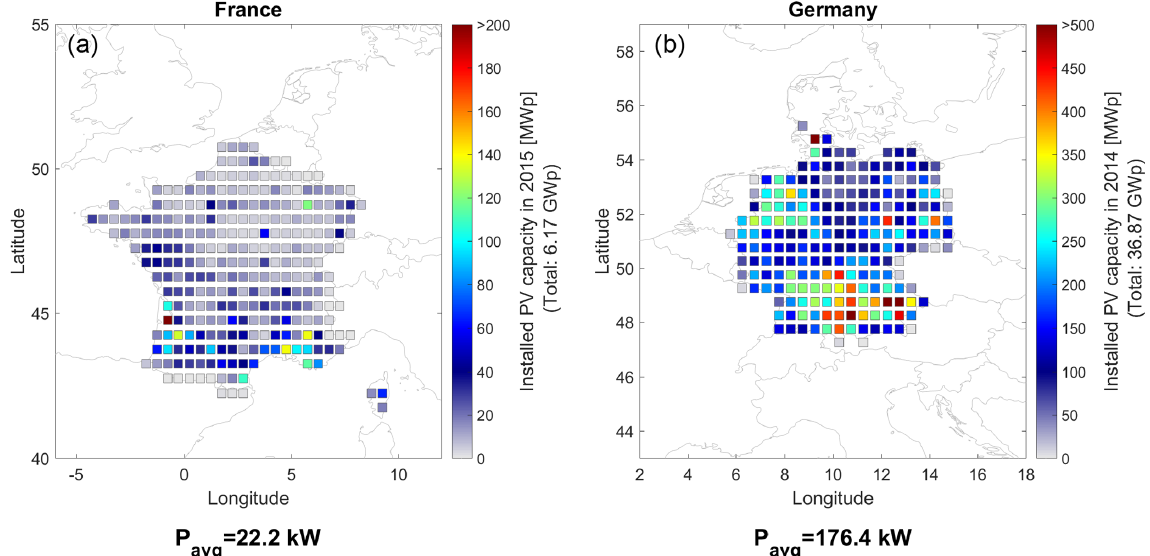
Figure 5. Spatial distribution of the installed PV capacity in France (a) and Germany (b) considering the actual spatial distribution of the installed capacity. Note that the scales in the two panels are different.